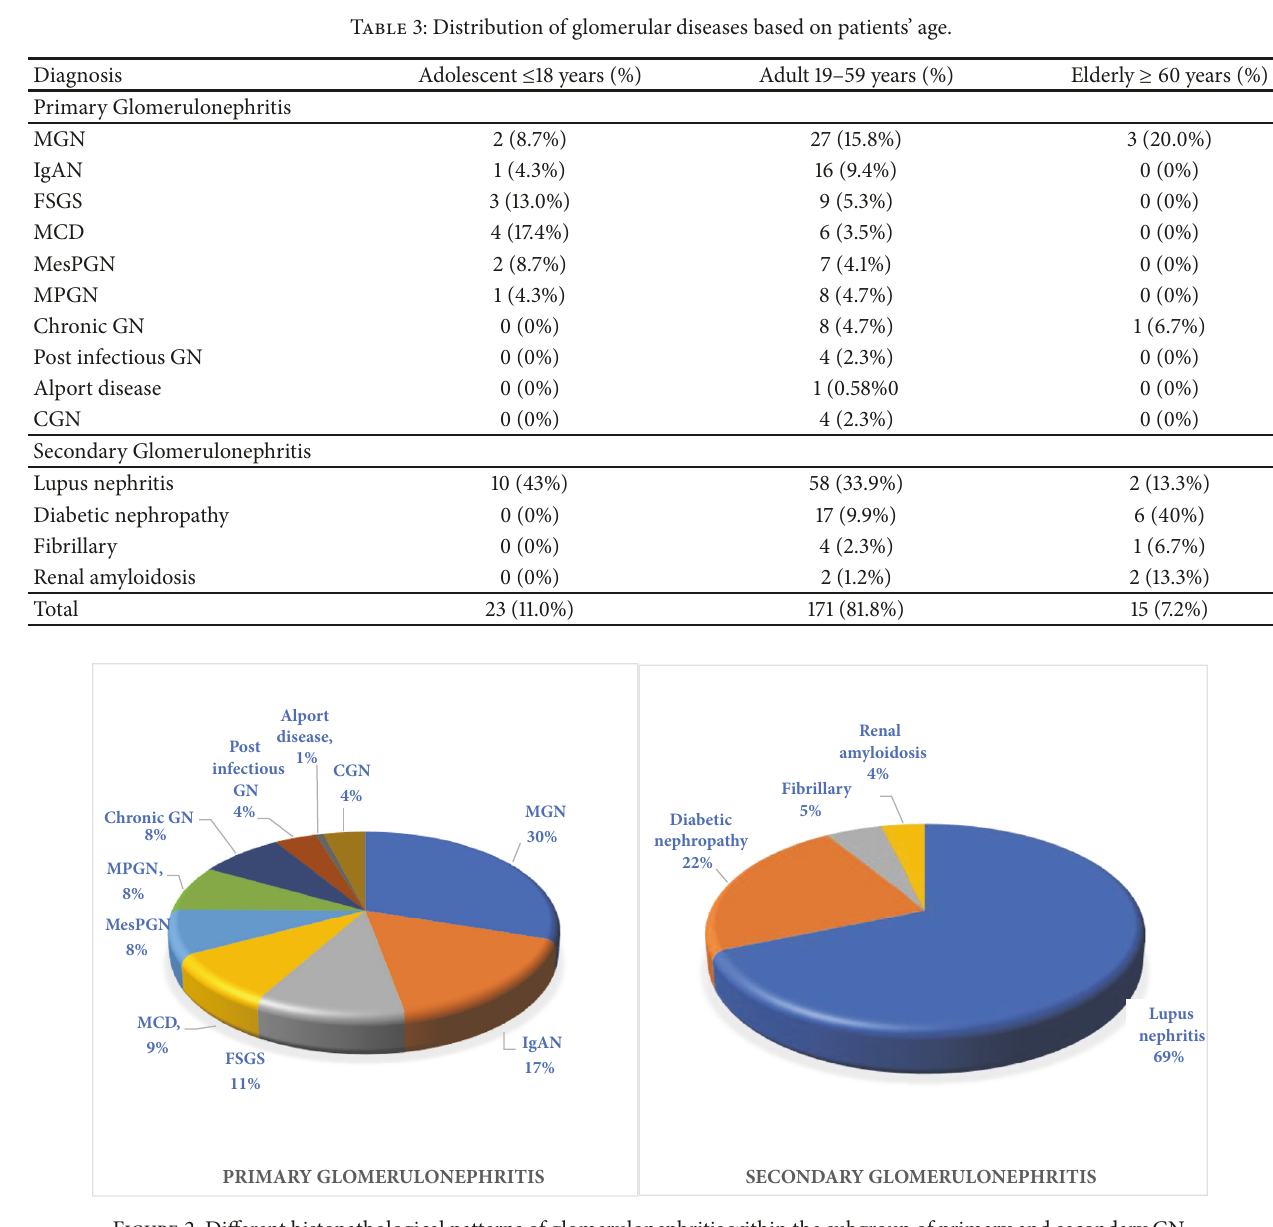
Figure 2: Different histopathological patterns of glomerulonephritis within the subgroup of primary and secondary